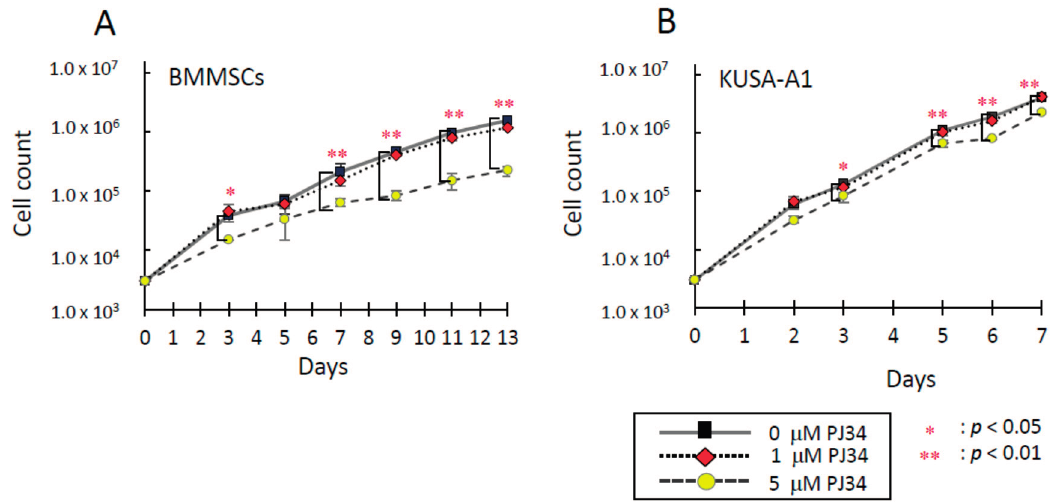
Figure 1. Cytotoxicity of PJ34 and AZD2281 on BMMSCs ( A ) and KUSA-A1 cells ( B ) were analyzed by survival assay. Cells were exposed to various concentrations of PARP inhibitors PJ34 and AZD2281 for 18 h, rinsed twice with PBS and allowed to grow for seven days. Values are expressed as mean ± SEM. * p < 0.05, ** p < 0.01, n.s. = no significance.